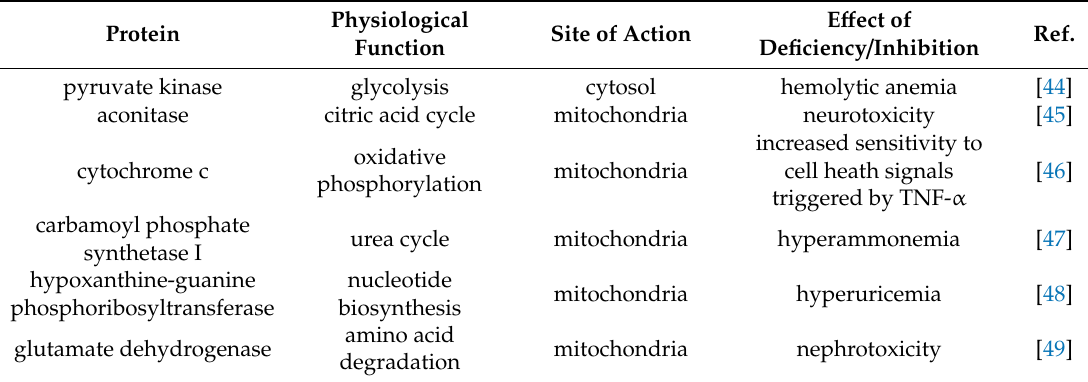
Table 3. Toxicity and side e ff ect-causing protein target of drugs.